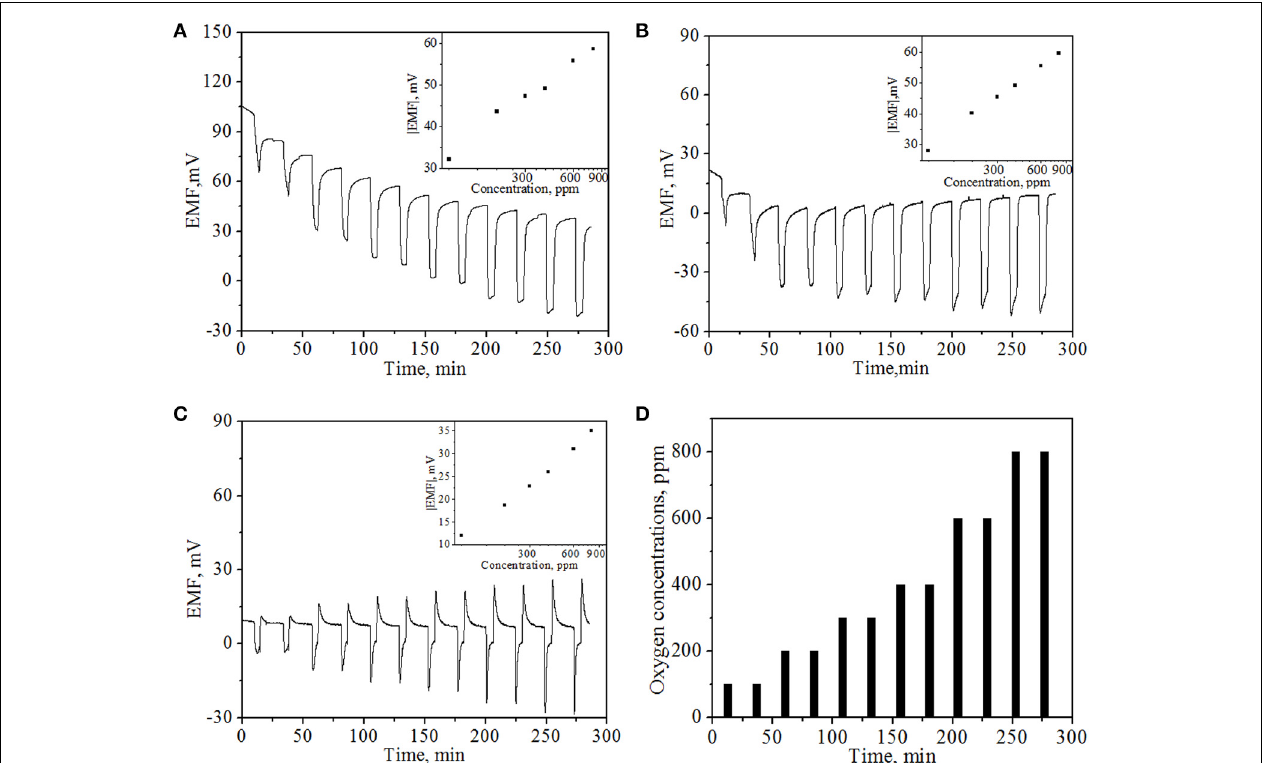
EMF values of the sensor at different O 2 concentrations. (D) The pattern of supplied oxygen with various concentrations in the oxygen gas sensing